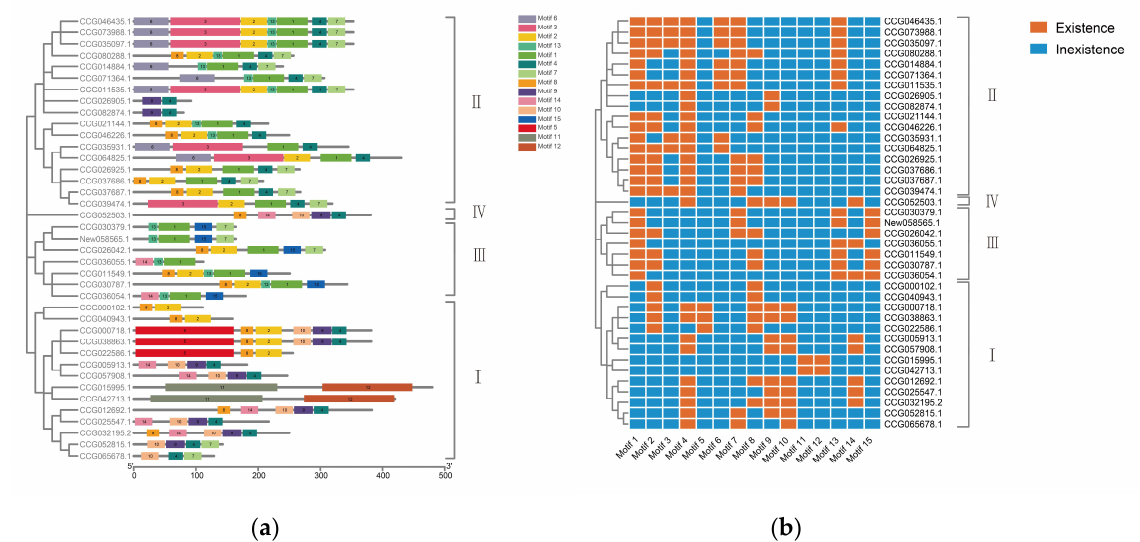
Figure 3. Conserved motifs of DDE_Tnp_4 family genes in E. sinensis . ( a ) The architecture of conserved protein motifs. ( b ) The heatmap indicates whether the meme motif existed in this gene. The orange modules imply that this gene contains this motif, while the blue ones do not.